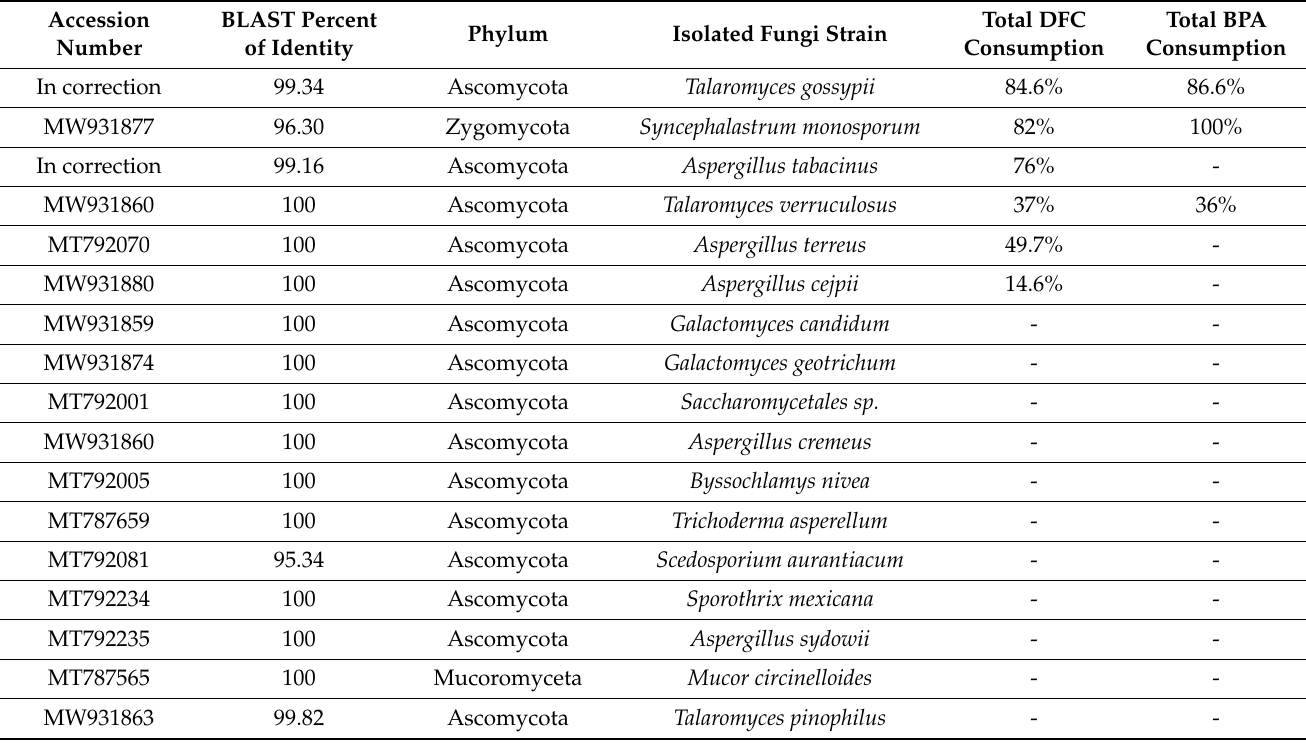
Table 1. Diclofenac and bisphenol A consumption rates and GenBank accession numbers of the fungal strains included in this